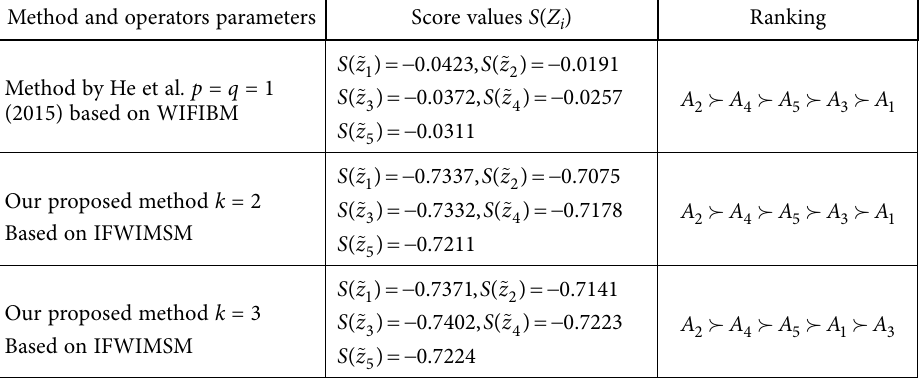
Our proposed method k = 2